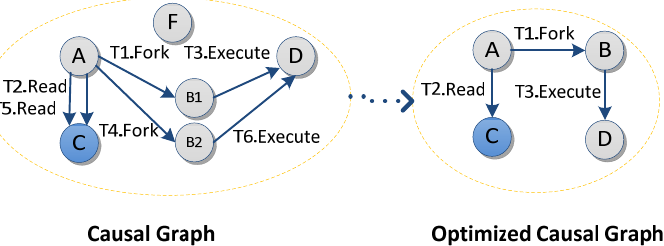
Figure 3. Graph optimization. An example causal graph ( left ) to illustrate reduction process. One malicious entity C is contained, while the others such as {A, B1, B2, D, F} ( left ) and {A, B, D} ( right ) are non ‐ malicious entities.